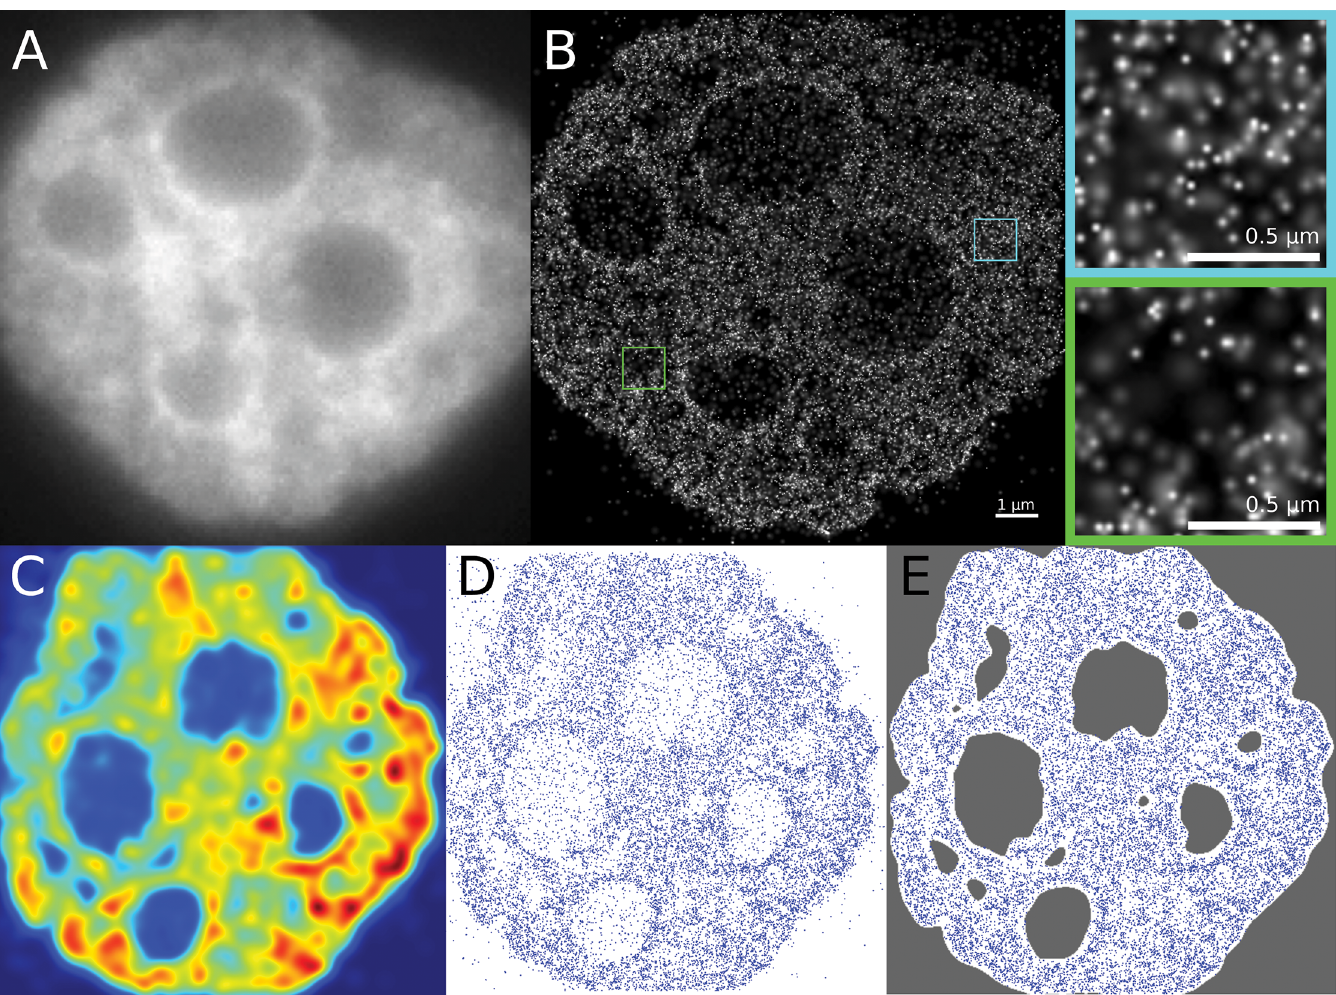
Fig 3. Localization Microscopy Images. Panel A. Widefield image of a cell nucleus, as usually obtained by standard microscopy. Panel B. Pointilist image obtained after merging the acquired time series of SPDM images. Each point represents a detected blinking process during image acquisition. The green insert shows an area with a low average density, which could correspond to euchromatin and the blue area corresponds to an area with high point density, possibly belonging to heterochromatin. Panel C. This panel shows the calculated density distribution of the localized markers using a Gaussian kernel density estimation with a uniform Gaussian kernels. Panel D. The figure shows the localized points of the image. From the points, areas with very low point density, possibly corresponding to nucleoli, can clearly be made out visually. Panel E. Shown is the segmented image where only the area of interest is kept for the analysis. The segmentation was based on the density distribution; areas below a threshold density were discarded for